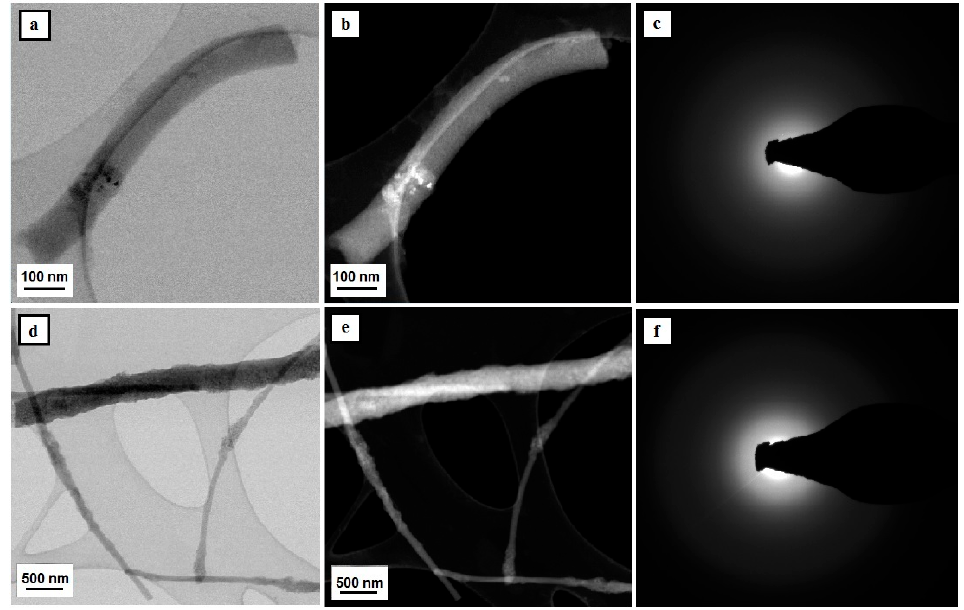
Figure 3. TEM images of the tested nanostructures – SiO 2 nanowires comprising a matrix for SiO 2 /SiO 2 NPs bimodal nanowires ( a , b , d , e ) along with diffraction images obtained with the use of analytical microscopy in nano areas in STEM mode and solved electronograms for nanoparticles and nanowires of silicon oxide ( c , f ).